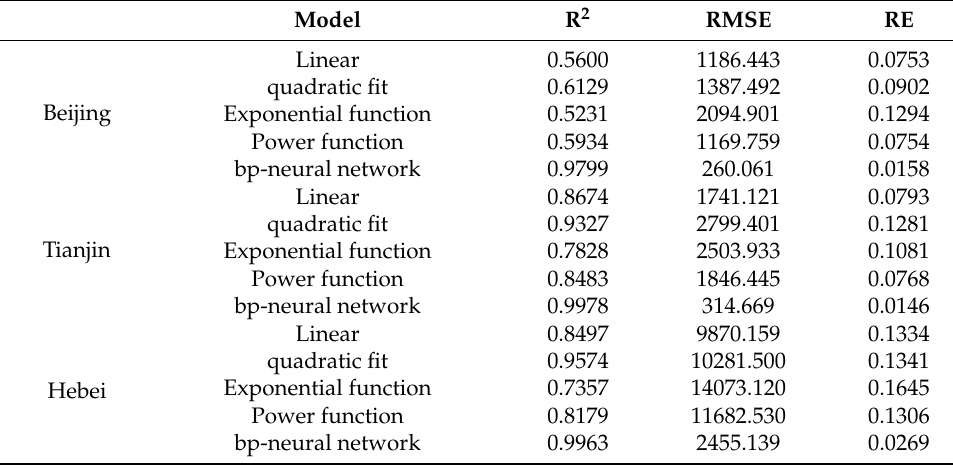
Table 4. Comparison of different function models.